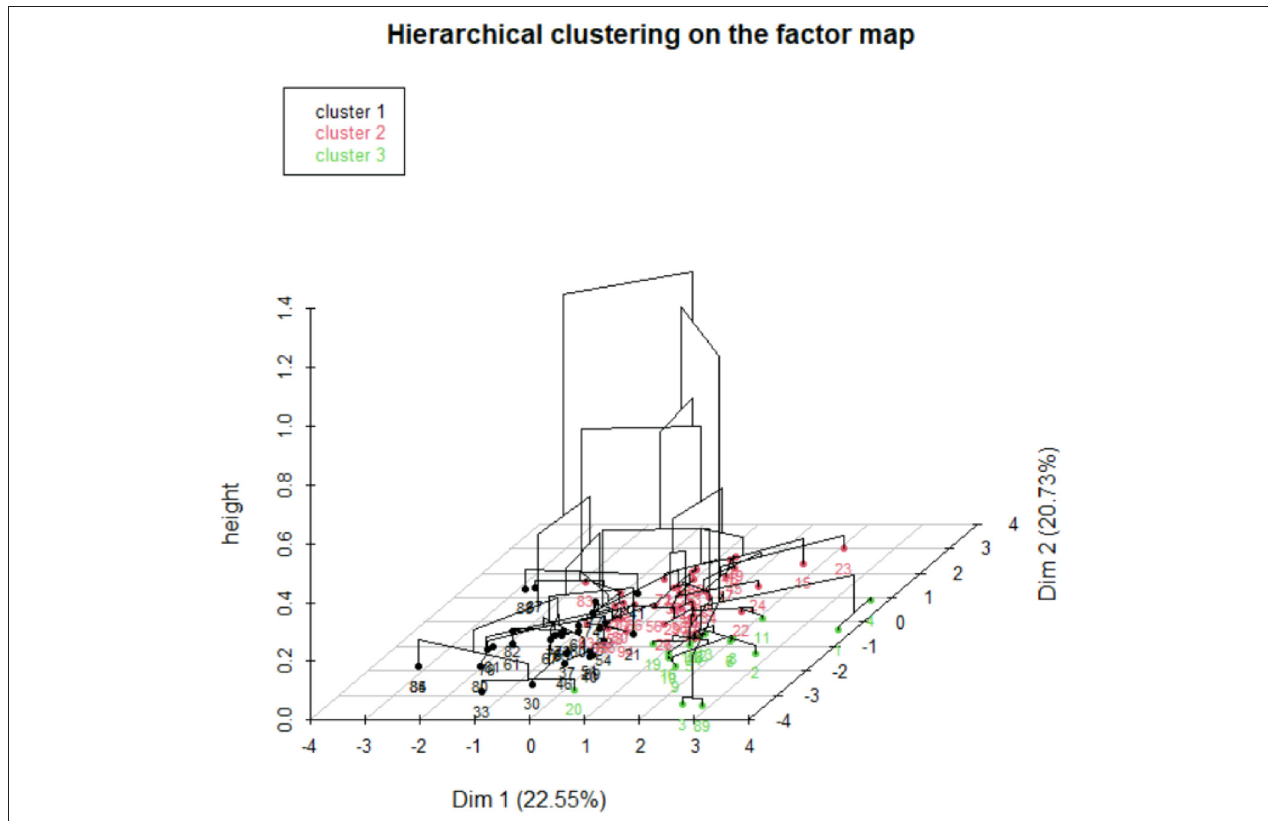
FIGURE 3 | Representation of three clusters of veterinary practices through hierarchical classification.